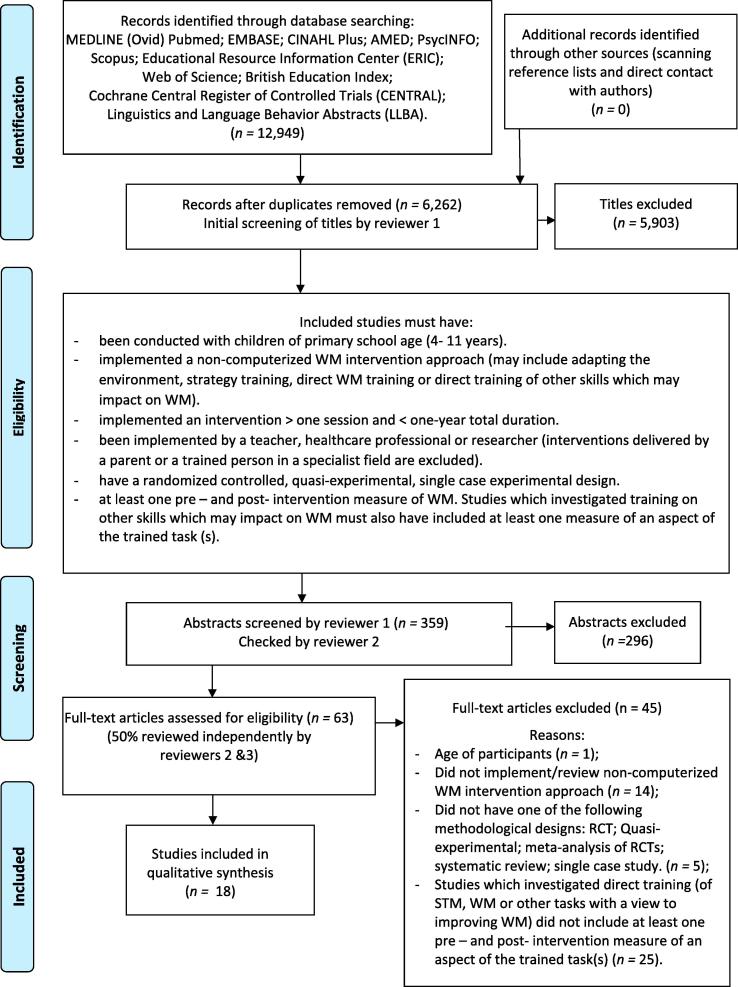
Flow Diagram for search strategy with criteria and reasons for exclusion following the PRISMA statement (Moher, Liberati, Tetzlaff, Altman, & The PRISMA Group, 2009).